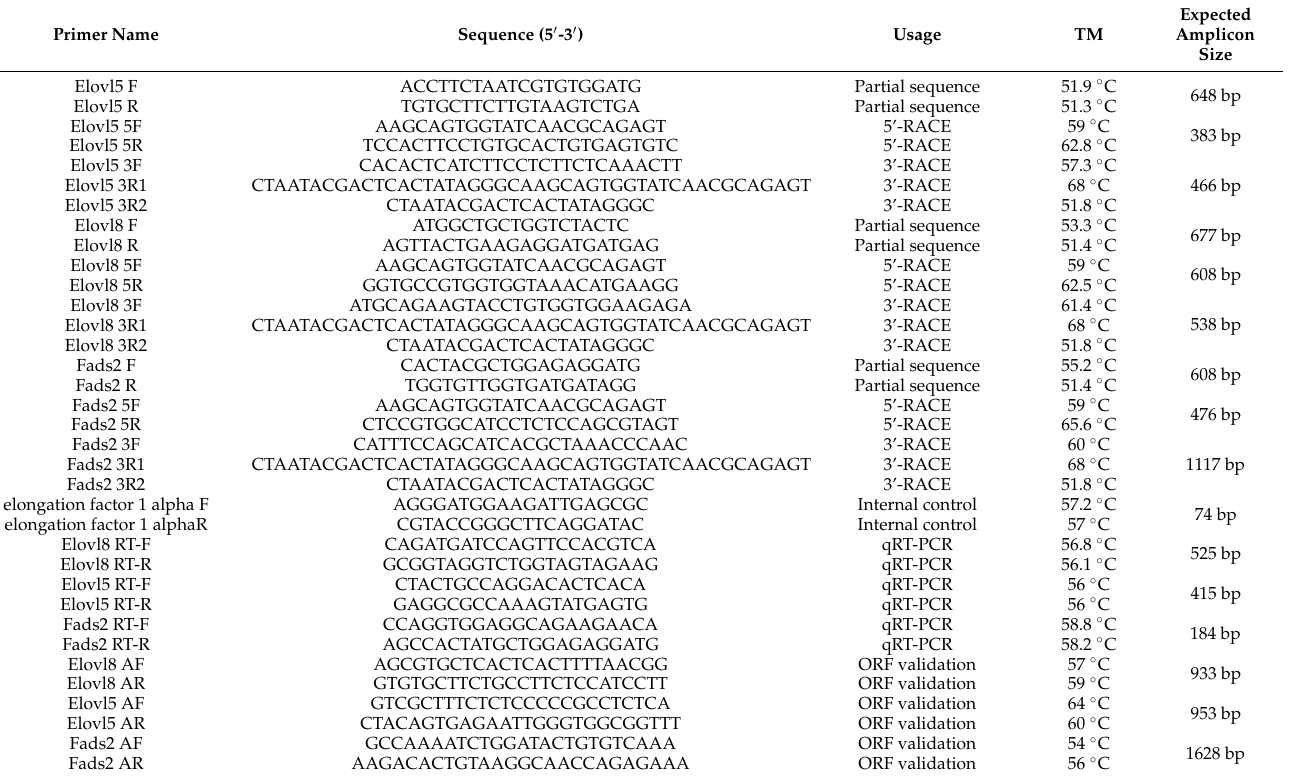
Table 1. Primers used for sequencing and qRT-PCR analysis of elovl5 , elovl8 and fads2 from hybrid